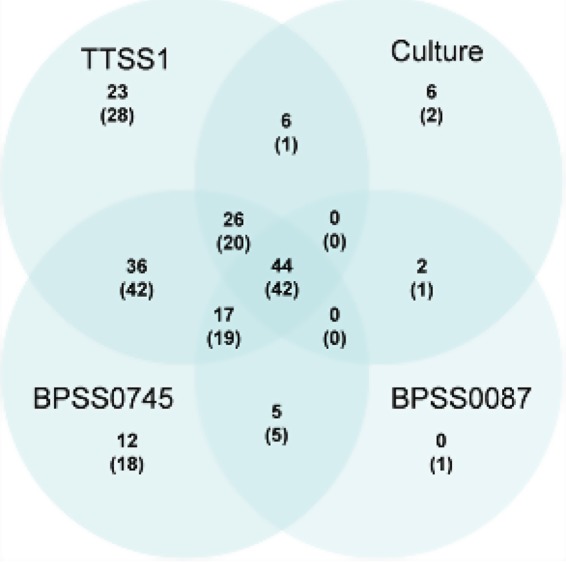
Venn diagram of B. pseudomallei detection in soil samples through a combination of different molecular (qPCR) assays and culture. Ten samples that were only positive by BPSS0745 qPCR and direct culture and one sample that was only positive by BPSS0087 and TTSS1 are not displayed. All six culture-positive and qPCR-negative samples were positive by BPSS1187 nested PCR (19).